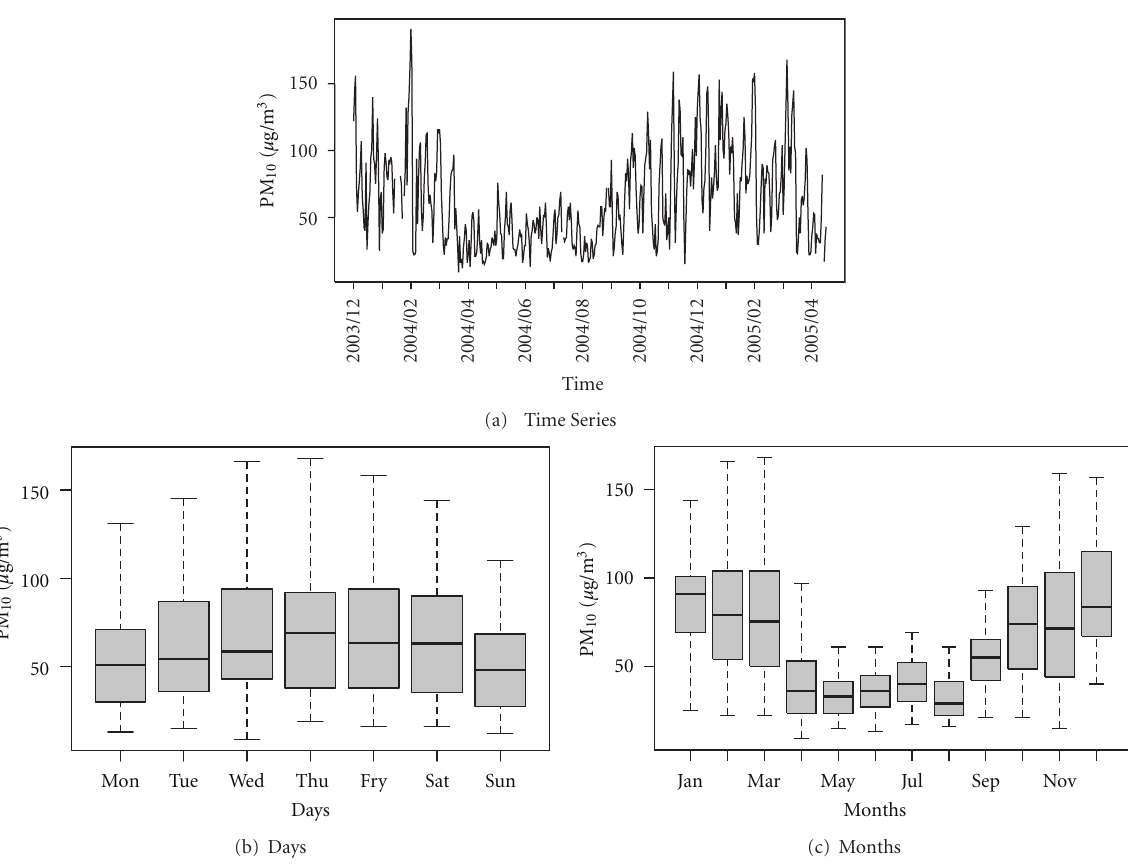
Figure 4: Time series and box plots for PM 10 concentration measured at Consolata